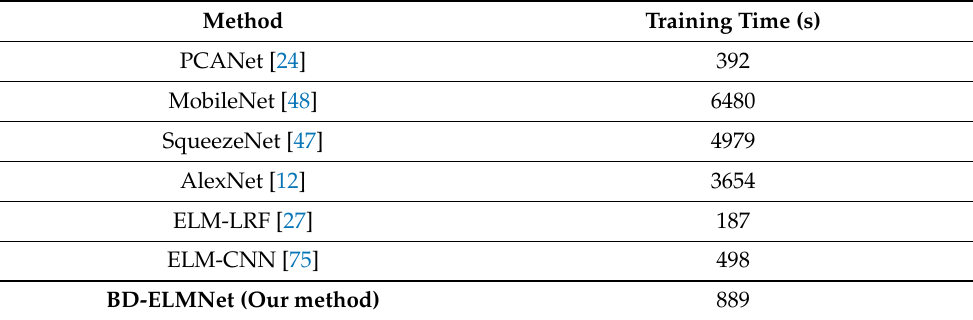
Table 6. Experimental results of different classification algorithms in terms of the computational